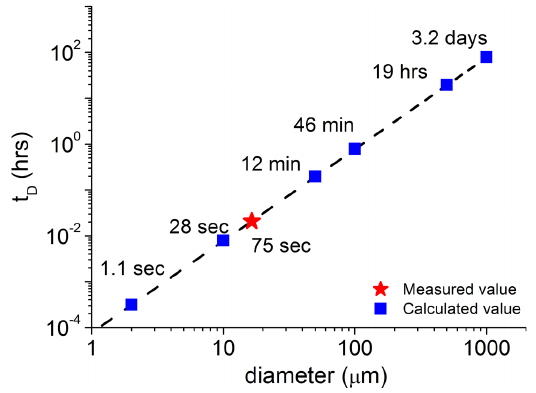
Figure 11. Ibp dissolution time t D vs. microparticle diameter. Blue filled squares are calculated values using Equation (8) and the red star is the measured value from Figure 10. using Equation (8) and the red star is the measured value from Figure